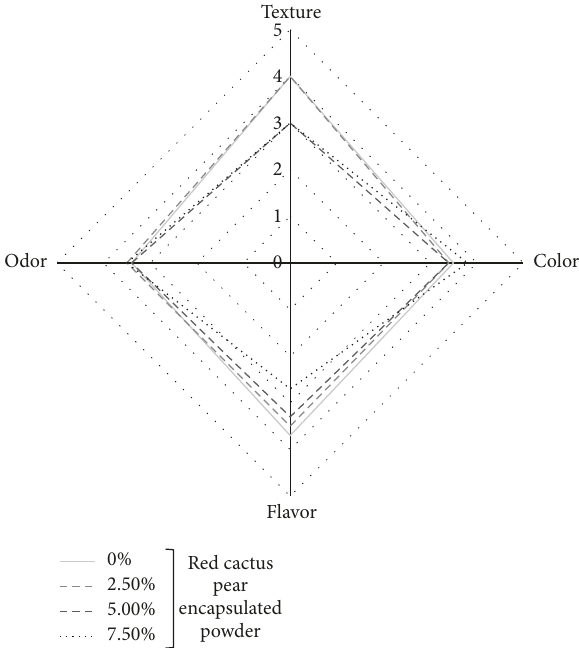
Figure 4: Sensory experience mapping on texture, color, flavor, and odor of extruded cereal pigmented with encapsulated powder of red cactus